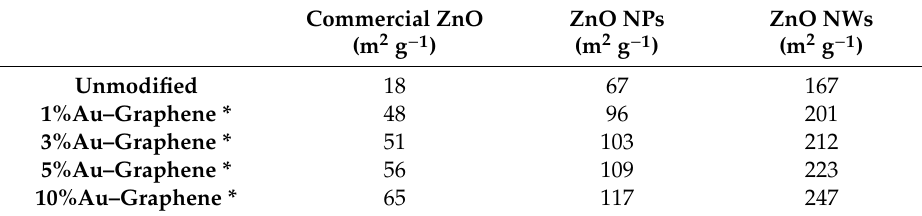
Figure 1. High resolution transmittance electron microscopy (HRTEM) images of 10%Au@commercial ZnO–graphene ( A ), 10%Au@ZnO NPs–graphene ( B ), and 10%Au@ZnO NWs–graphene ( C ). The red and yellow arrows indicate the presence of graphene and gold, respectively, and the insets correspond to the selected area of electron diffraction (SAED) patterns. Table 1. BET surface area of the Au@ZnO–graphene